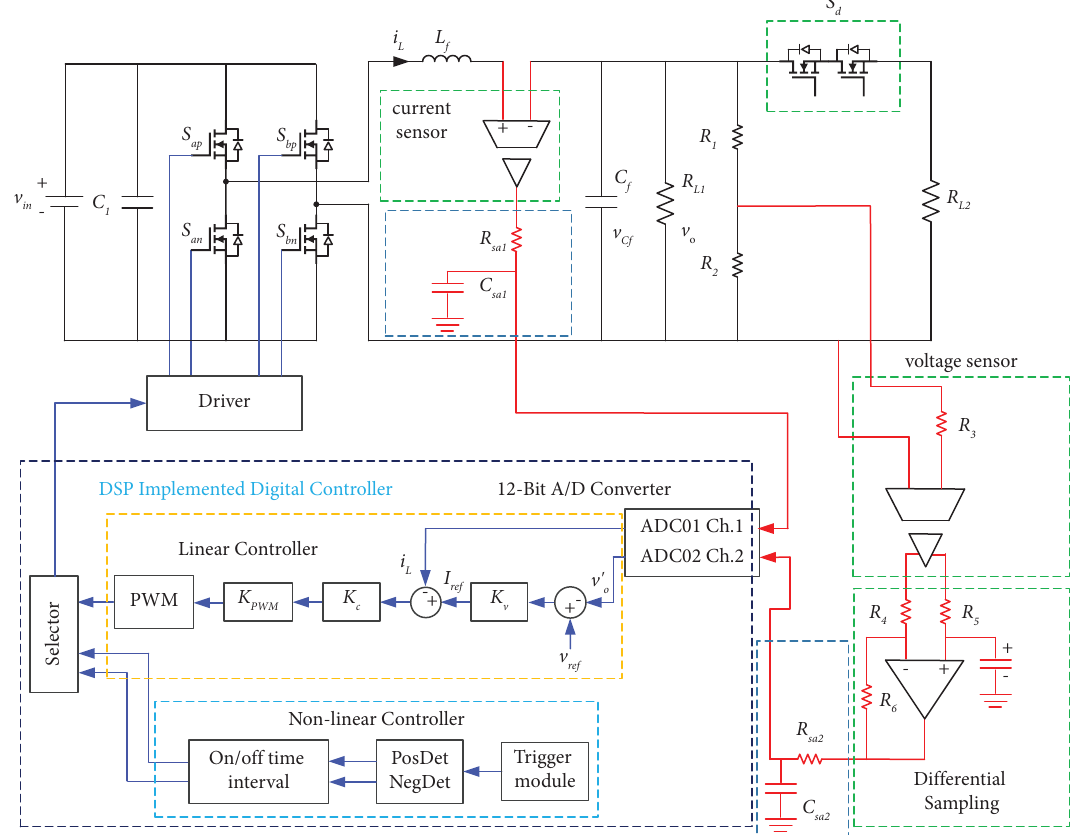
Figure 14: Te hardware implementation block diagram of the proposed controller.